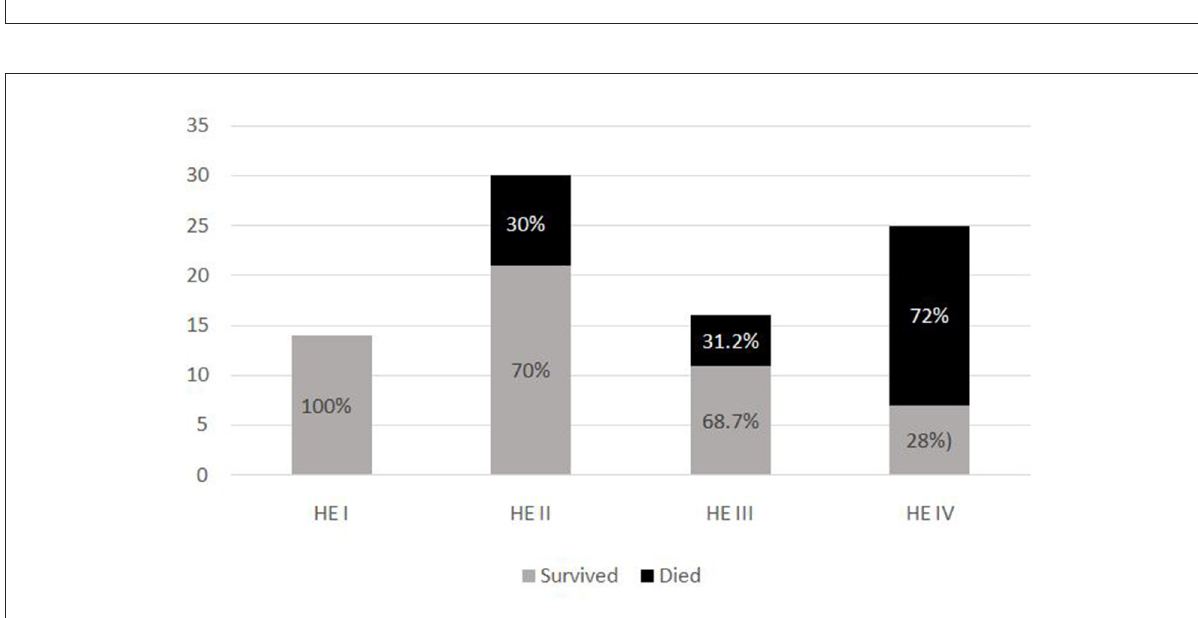
FIGURE3 Outcome of patients based on grades of hepatic encephalopathy.